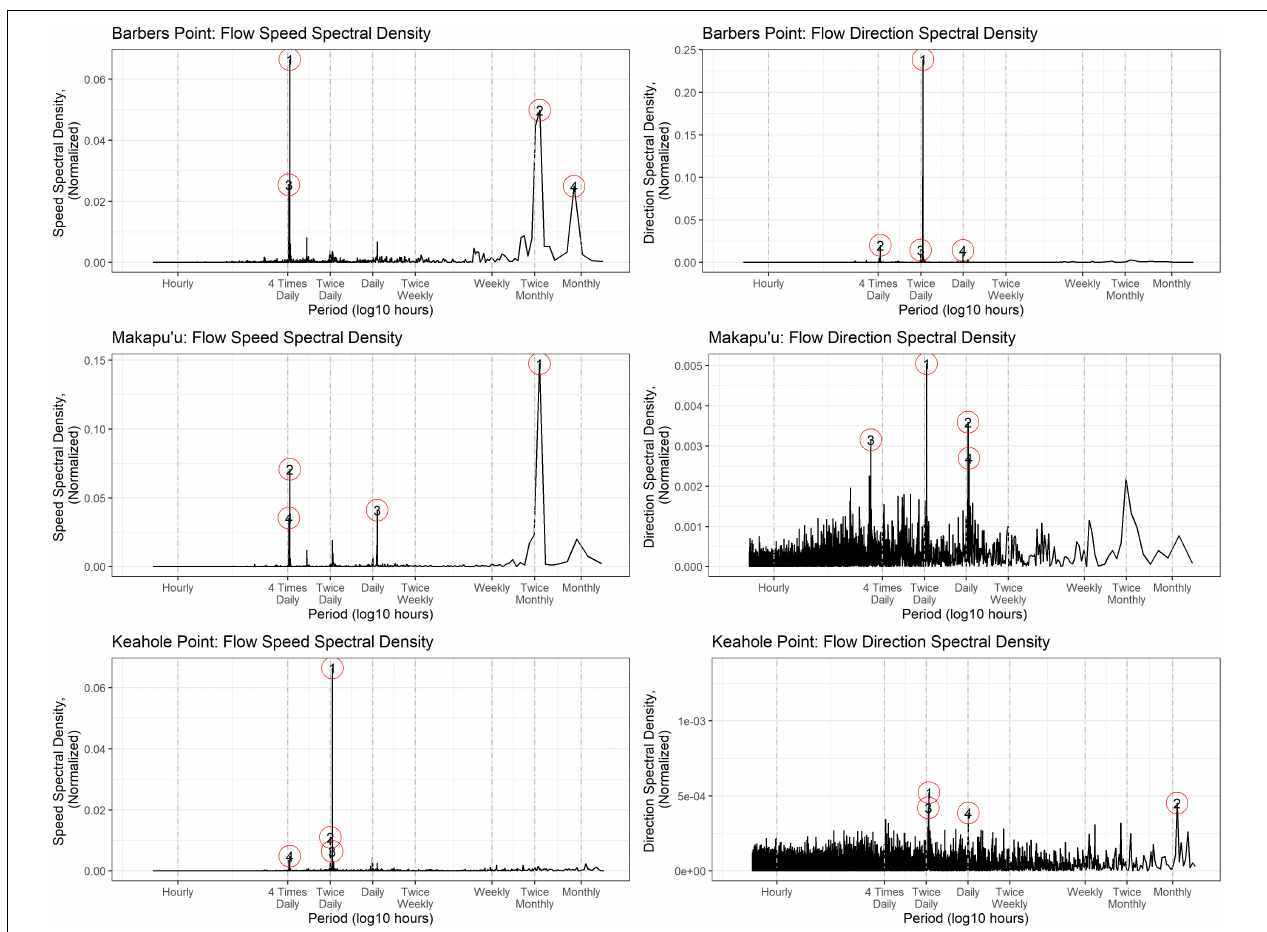
FIGURE 5 | Left column: Temporal plots of spectral density of flow speed for the three coral patches showing peak changes just under twice daily, consistent with tidal influences. Right column: Tidal spectral effects on current direction for the three patches on a weekly scale.